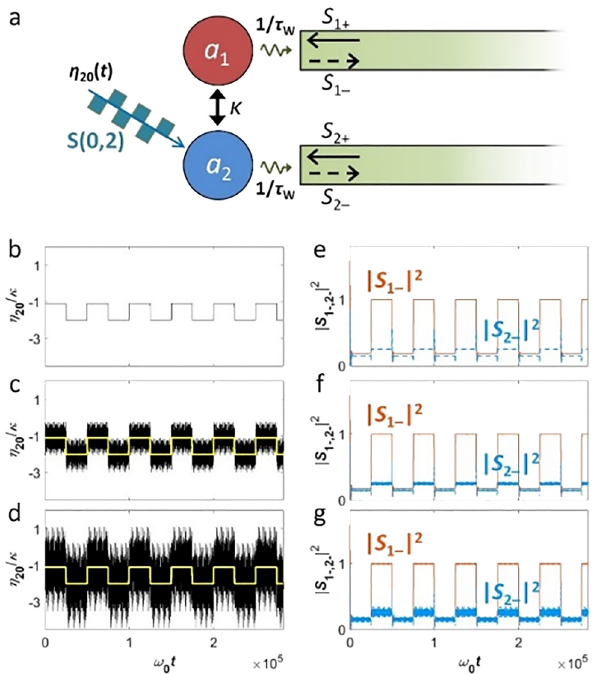
Figure 4: Noise-immune laser modulation. (a) Schematic of the platform. (b – g) Noise-suppressed laser modu- lations: (b – d) κ -normalized modulation signals η 20 ( t ) with different noise levels and (e – g) output signals | S 1 − | 2 and | S 2 − | 2 . The signal in